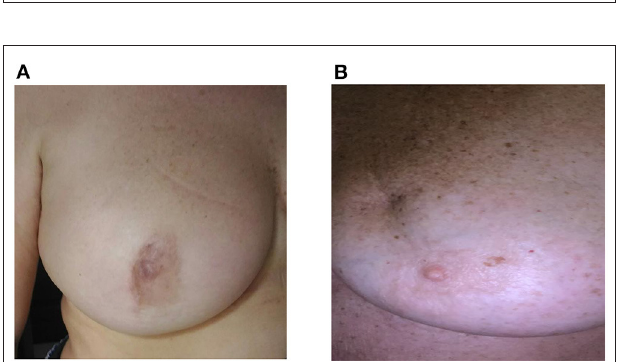
FIGURE 1 | About 5-year actuarial disease-free survival (DFS). About 1–5-year disease-free survival rates in 75 patients undergoing surgery for early breast cancer. Group 1 refers to 38 patients undergoing standard quadrantectomy. Group 2 refers to 37 patients undergoing totally subcutaneous quadrantectomy.